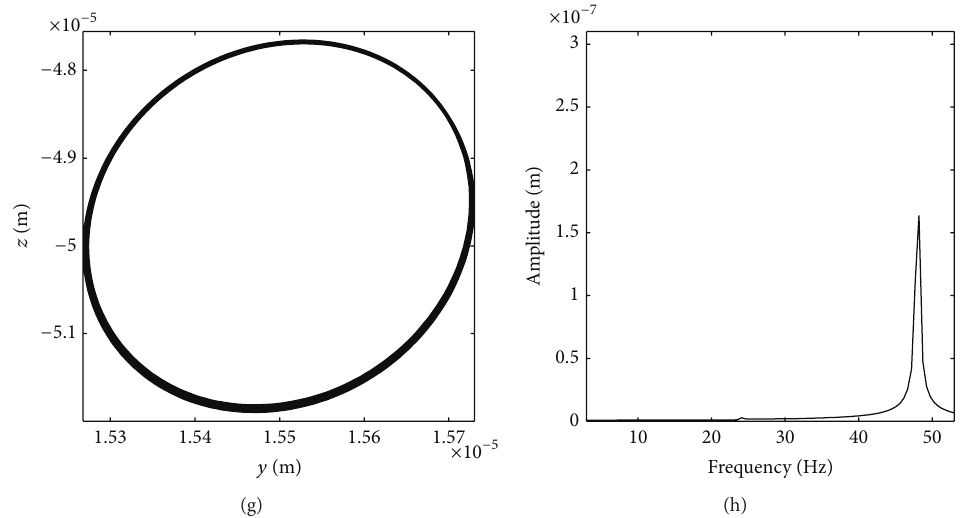
Figure 10: Simulated results of the first bearing in configuration A for constant rotational speeds (see Figure 8(a)): (a) orbit at 10Hz; (b) frequency spectrum at 10Hz; (c) orbit at 26Hz; (d) frequency spectrum at 26 Hz; (e) orbit at 35 Hz; (f) frequency spectrum at 35 Hz; (g) orbit at 48 Hz; (h) frequency spectrum at 48